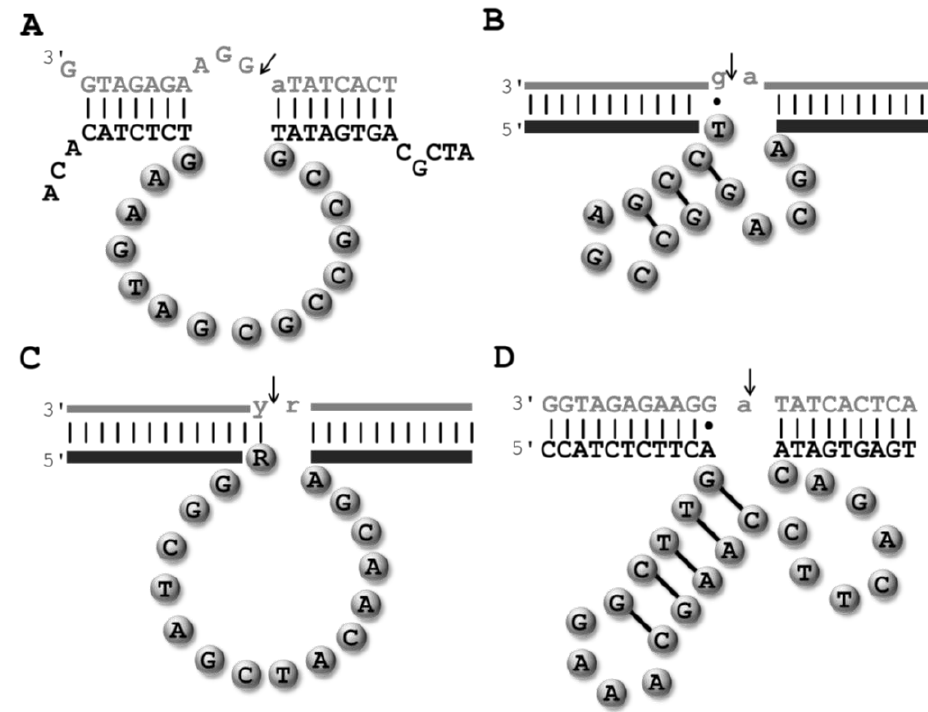
Figure 3. Putative schematic representations of the putative secondary structures of RNA-cleaving DNAzymes: ( A ) the first RNA-cleaving Pb 2+ -dependent DNAzyme to have been isolated by in vitro selection [20]; the all-RNA cleaving DNAzymes 8-17 ( B ) and 10-23 ( C ) [31]; and ( D ) the UO 2 2+ -dependent RNA cleaving DNAzyme E Hg 0T [59]. The substrates are shown in grey and thin lines and lower case letters represent RNA units, while thick lines and upper case letters represent stretches of DNA nucleotides. The cleavage sites are indicated by an arrow.